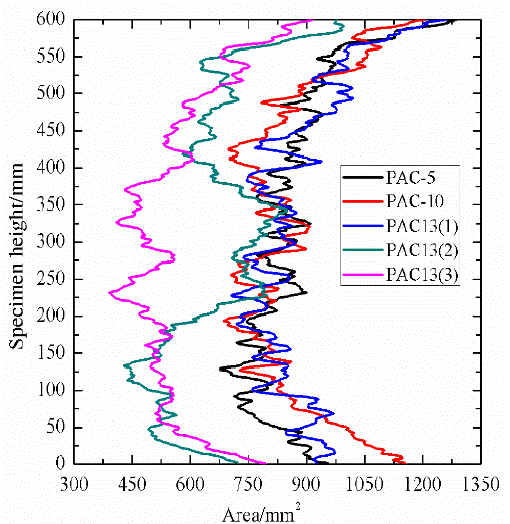
Figure 5. Area of pores along the specimen height direction.